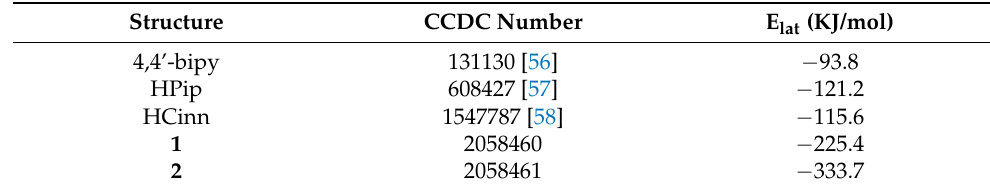
Table 4. Lattice energy (E lat ) of the crystal structures of the starting materials and cocrystals 1 and 2 . All the values have been obtained using CrystalExplorer 17.5 from the corresponding .cif files. Structure